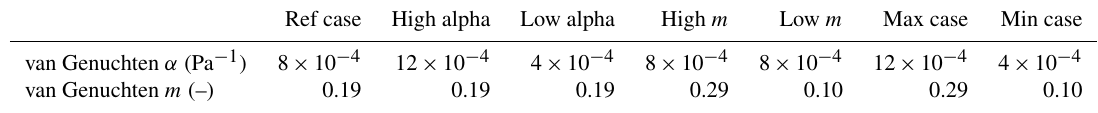
Table 4. Van Genuchten parameters α and m (Eq. 2) consistent with silt textures and as assigned in the seven model scenarios.